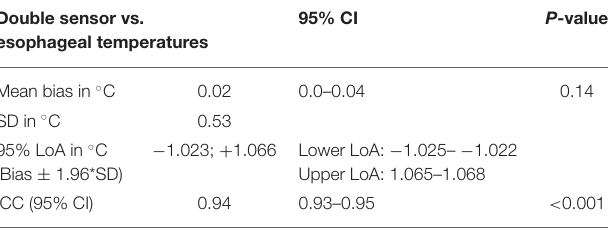
Epidemiologic data for the remaining patients are listed in Table 2 .